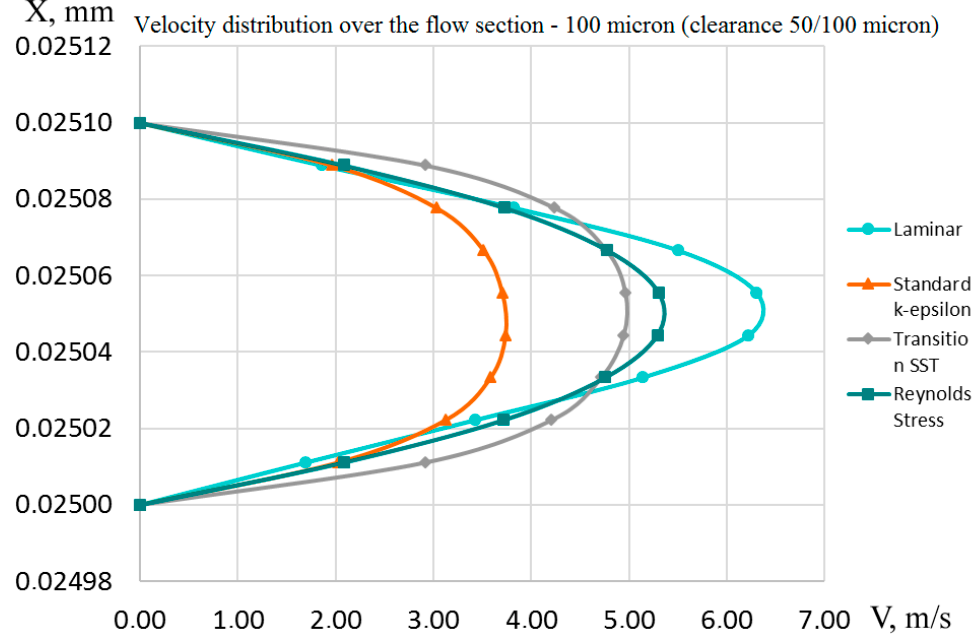
Figure 18. Velocity distribution over the flow section (laminar and transition SST surves match).